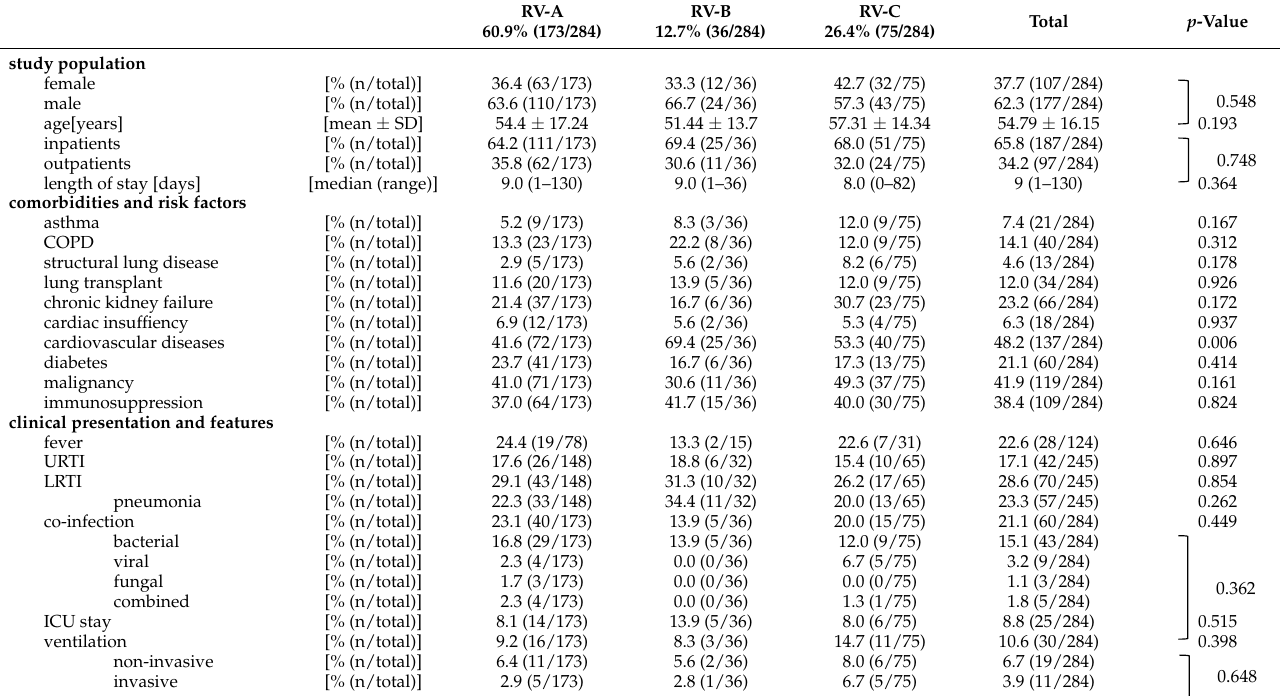
Table 2. Study population and clinical features of RV cases.